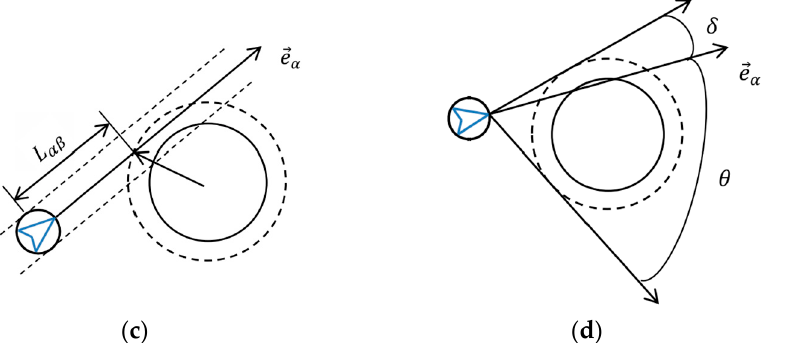
Figure 4. Schematic diagram of force. ( a ) Human location according to export; ( b ) export attractiveness; ( c ) application of reject force; ( d ) angle of deflection.